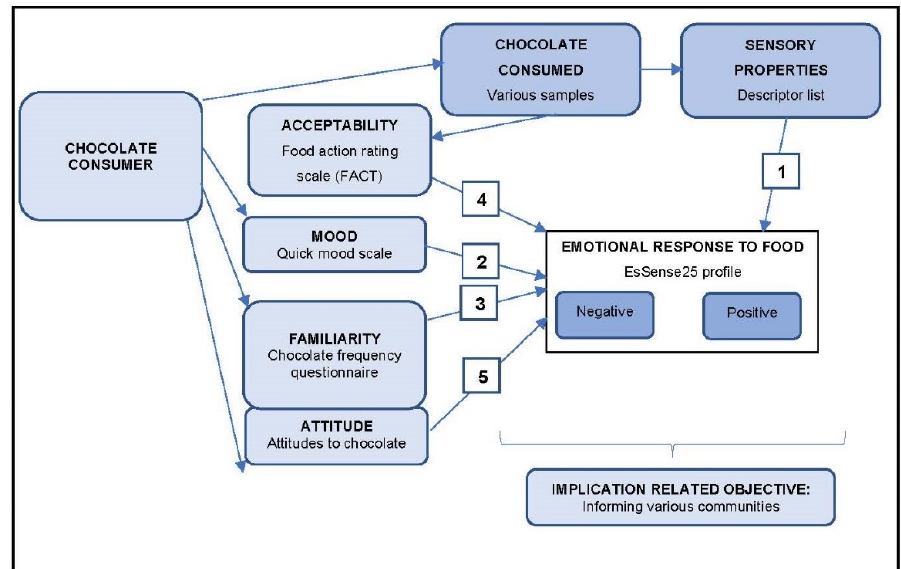
Figure 1. Framework of the study.